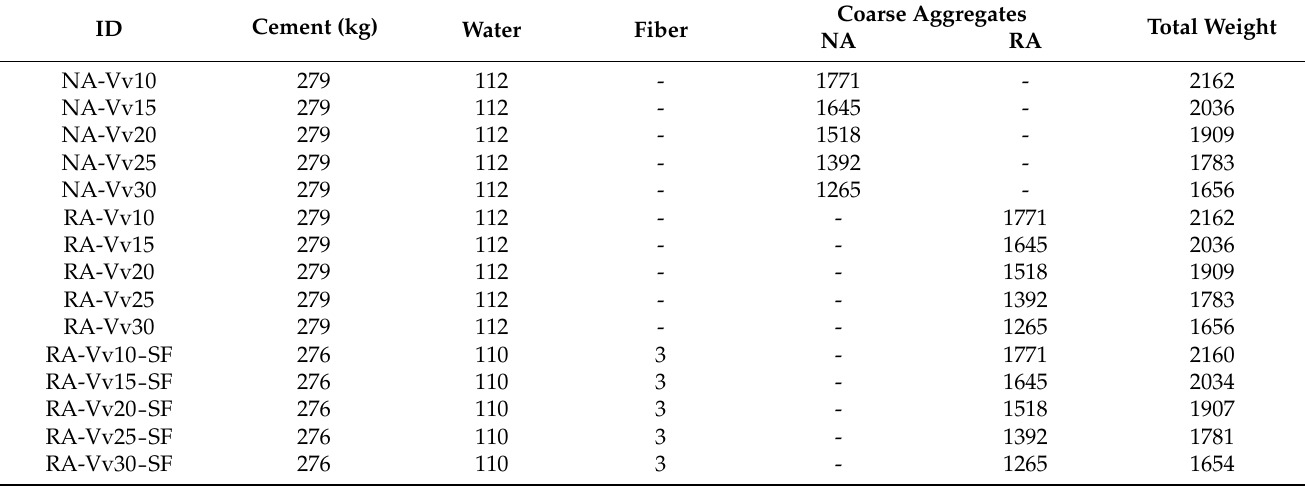
Table 2. Details of mix components